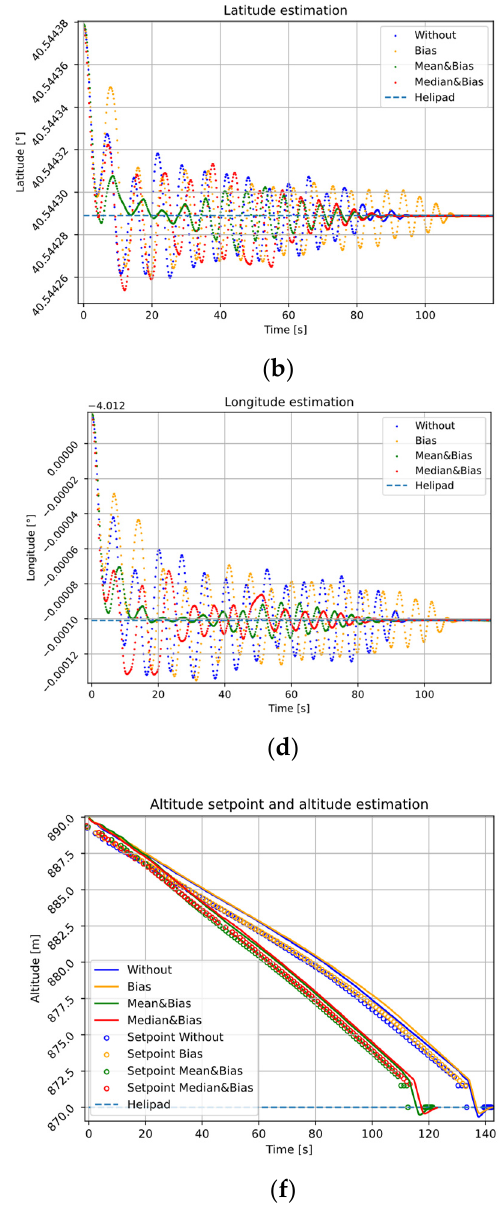
( d ) Figure 14. Five-flight 3D graphics for each of the four groups: ( a ) without correction; ( b ) bias cor- rection; ( c ) bias and mean filter; ( d ) bias correction and median filter. Figure 15 illustrates the temporal behavior of each analysis group, showing the three global position components: latitude, longitude, and relative altitude. In addition, our proposal is comparing with linear descent, paying special attention to altitude evolution Figure 15e,f. In this case, estimated altitude and setpoints are shown for the exponential